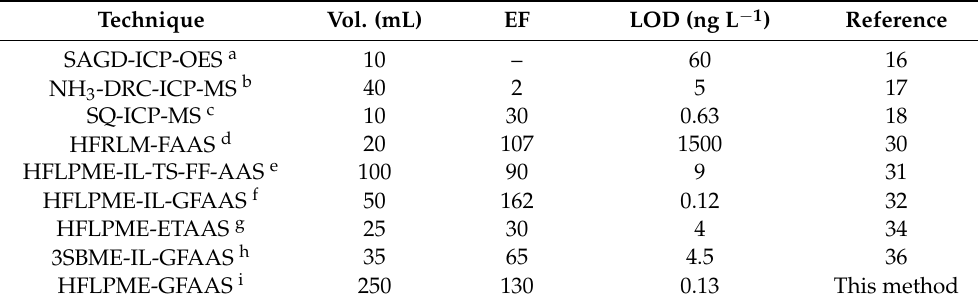
Table 2. Comparison of the proposed method with other reported